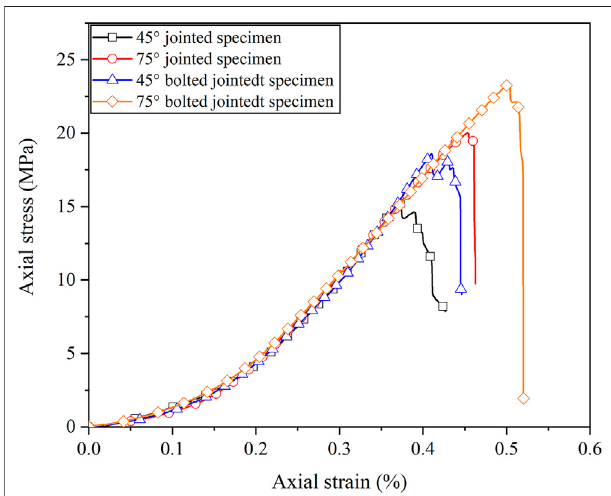
FIGURE 3 | Stress – strain relationship of jointed and bolted jointed